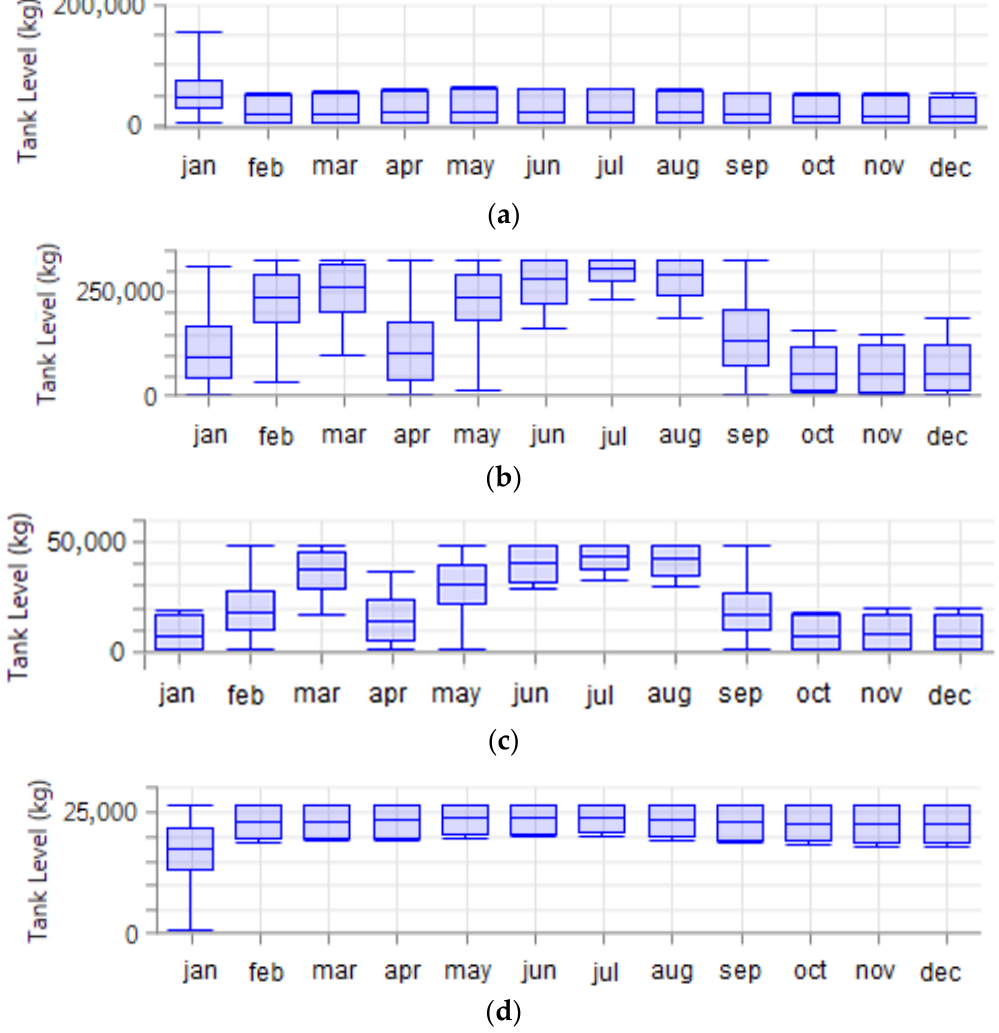
Figure 13. Monthly data of the reverse pumping storage system. ( a ) Tenerife; ( b ) Gran Canaria; ( c ) La Palma; ( d ) La Gomera.